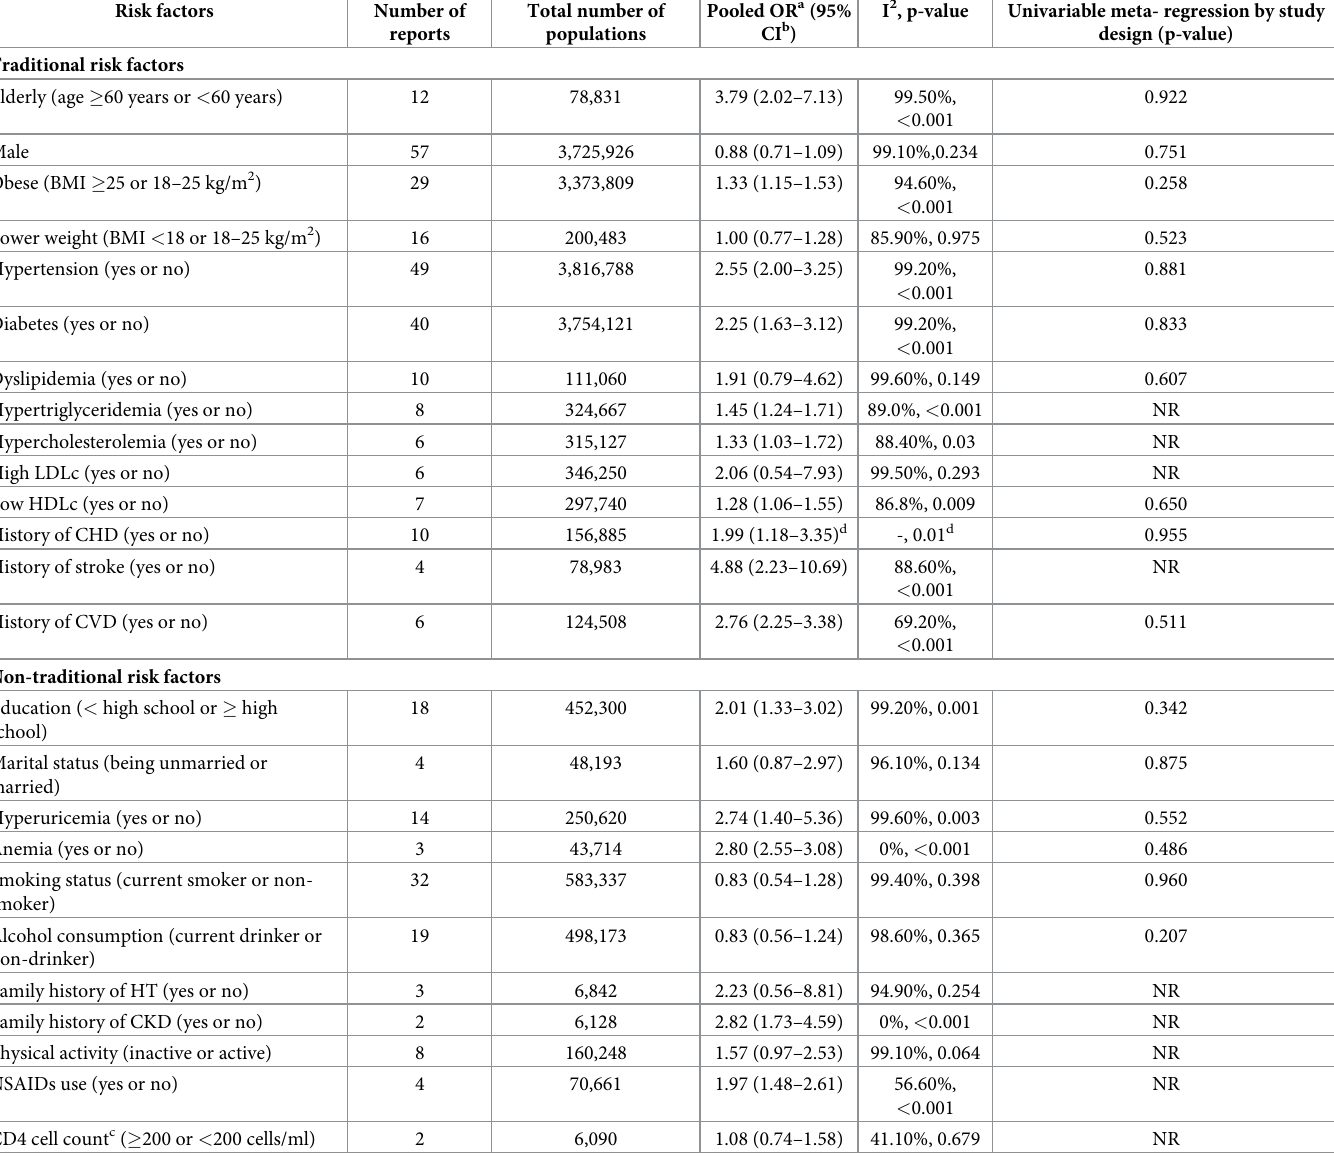
Table 3. Pooled estimate odd ratio and meta-regression: The effect of traditional risk factors and non-traditional risk factors on prevalence of chronic kidney dis- ease (CKD) stage 3–5 in low- and middle-income countries (LMICs) in